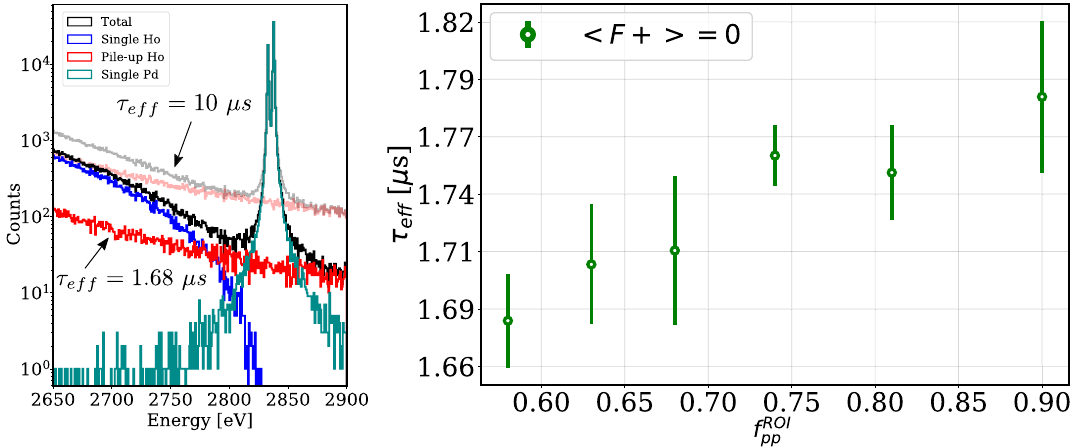
Fig. 7 Left panel: ROI energy spectrum with Pd L α peaks before and after the application of the DSVP technique. The initial f ROI pp was set to 0.58. Right panel: The dependence of τ ef f from the f ROI pp is shown